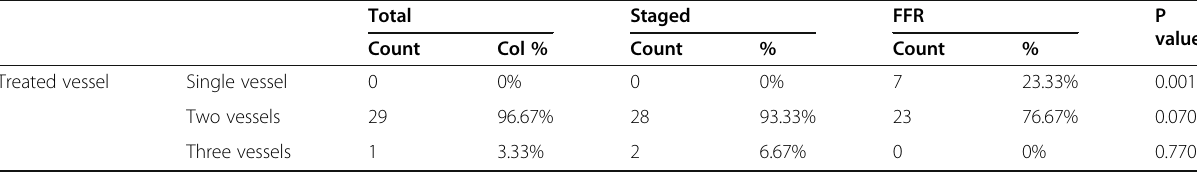
Table 2 The short-term outcome of the three groups. After 6 months, there was an office- or/and telephone-based interview done with each patient to evaluate the short-term outcome of the management plan. Two patients in both the total and the FFR groups were hospitalized due to unstable angina, and this was compared to 4 patients in the staged group. The staged group had the greatest incidence of complication between the three groups as there were 6 patients (20%) who suffered complications during this period